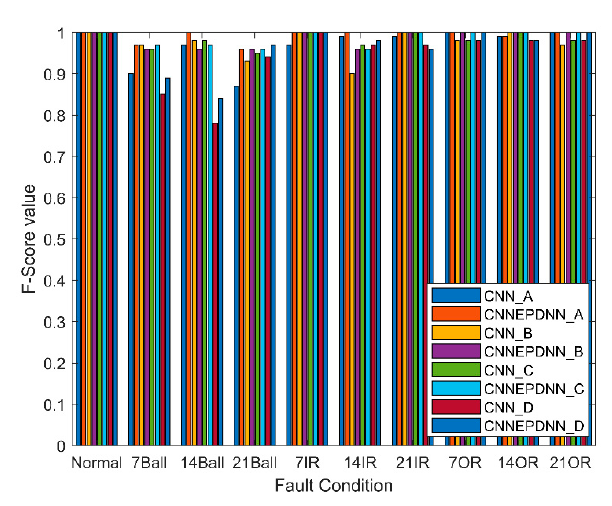
Figure 10. F-Score value of ten condition fault in four dataset.